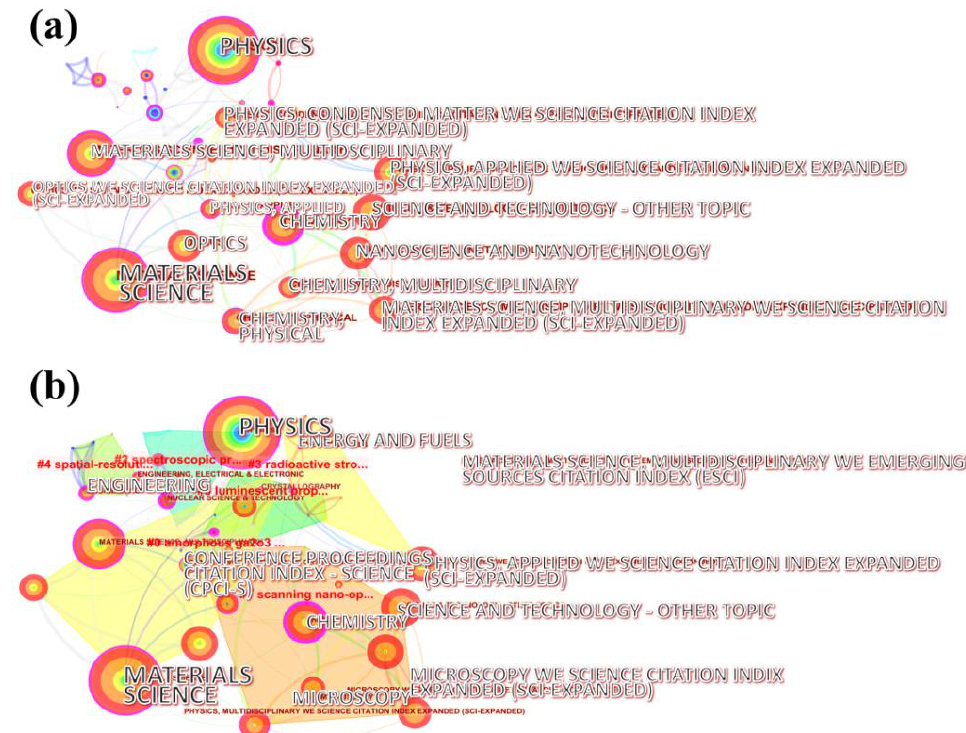
Figure 5. Category visualization atlas ( a ); map after clustering ( b ).